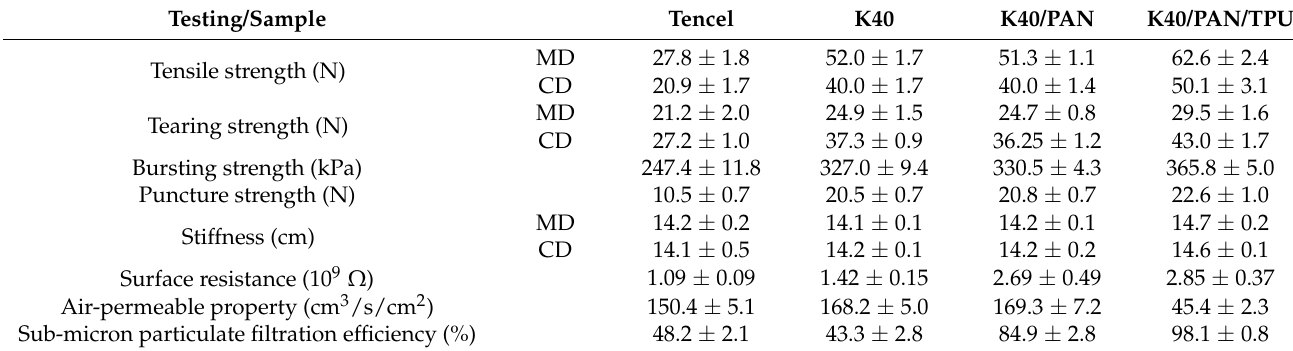
Table 4. Data of mechanical properties (N ≥